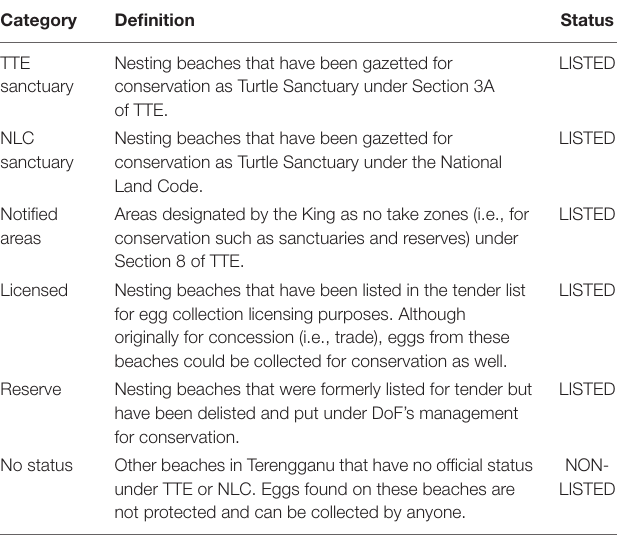
TABLE 1 | Categories of nesting beaches that exist in